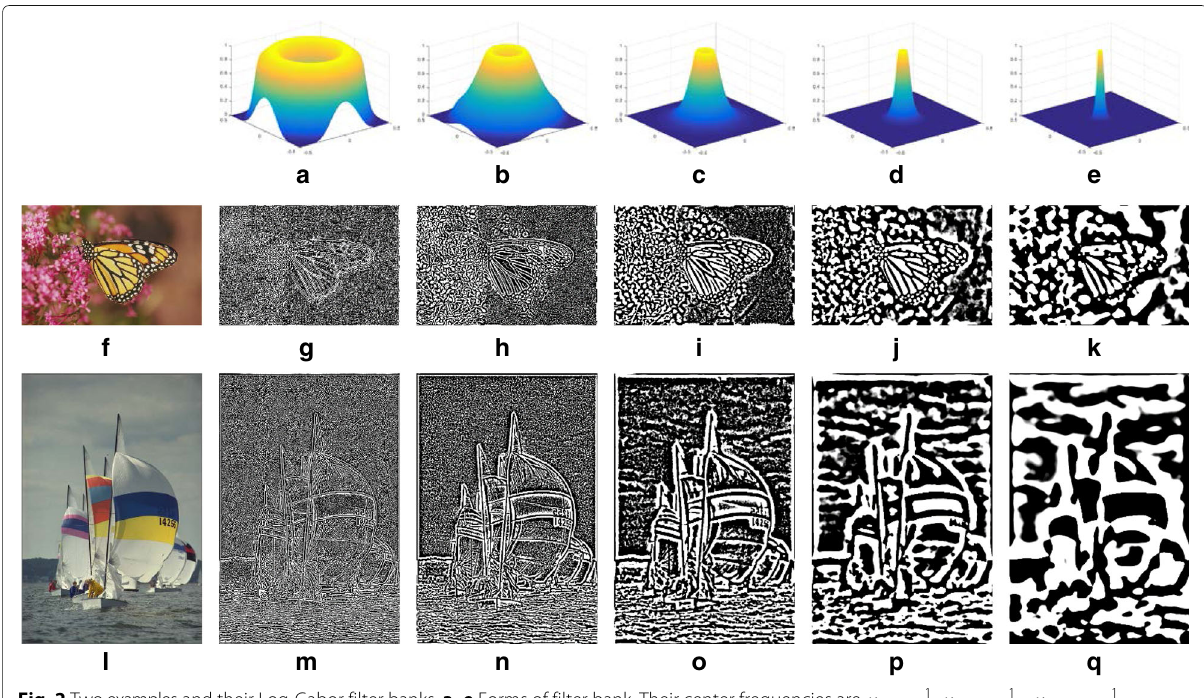
, ω 02 = 1 , ω 03 = 1 , 3 3 2.1 3 2.1 × 2.1